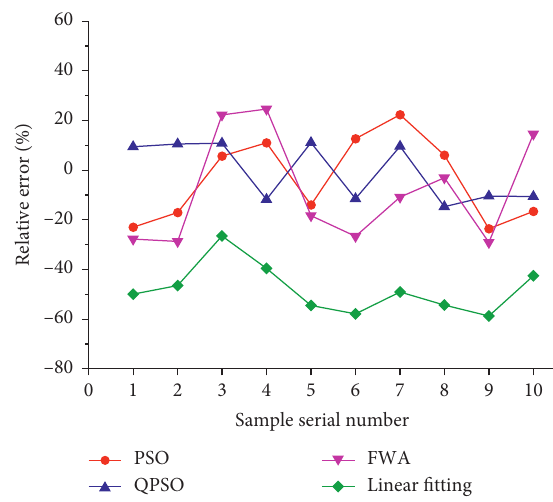
Figure 15: The prediction error curve of h